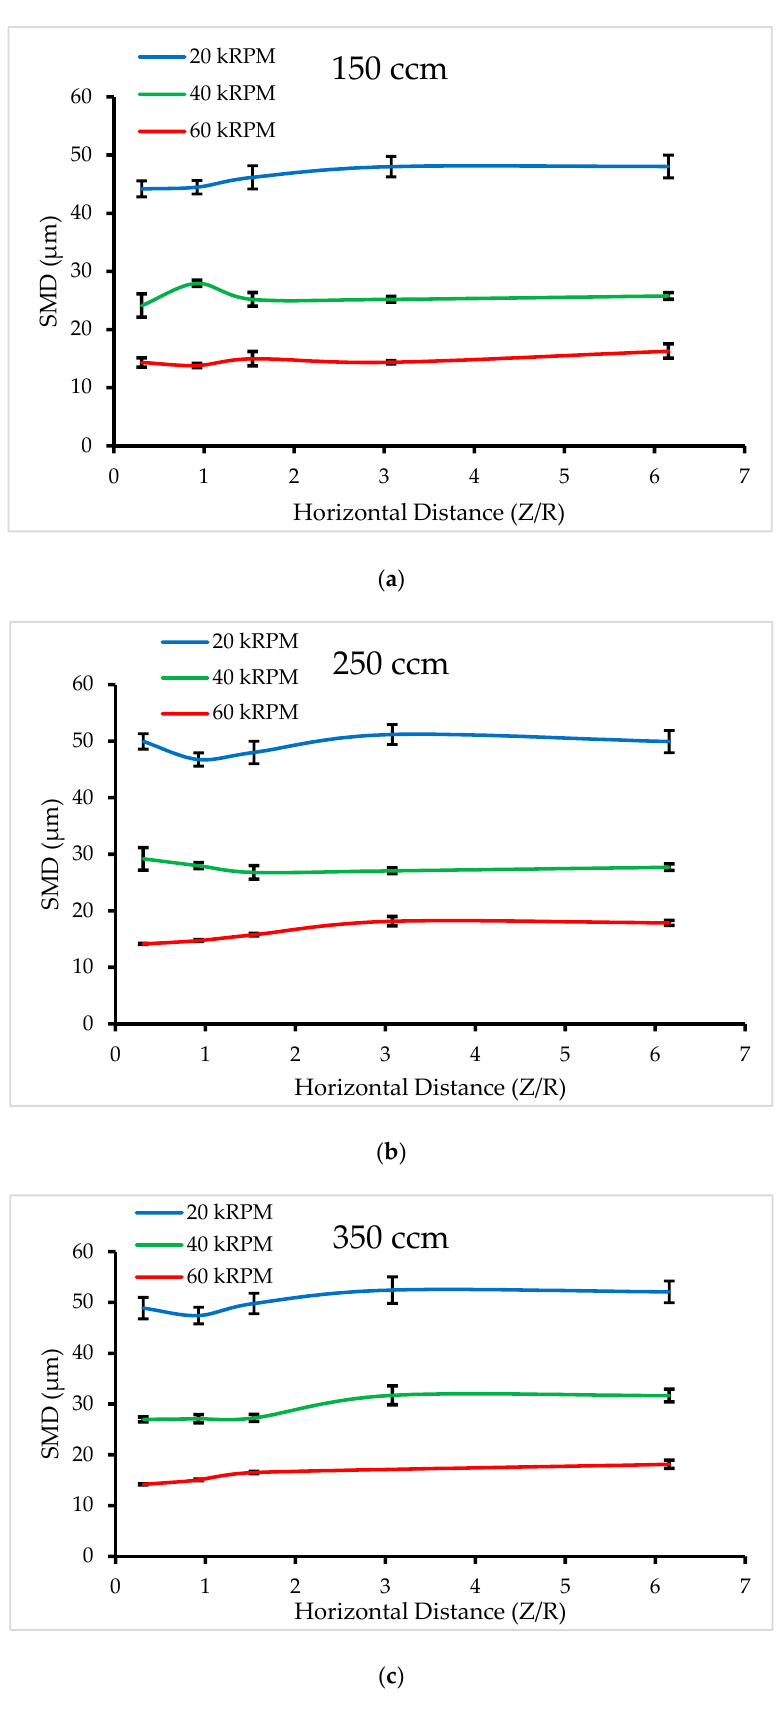
Figure 13. Comparison of the D 32 versus the lateral location from cup edge at the central axis, for three di ff erent rotational speeds and three di ff erent fluid flow